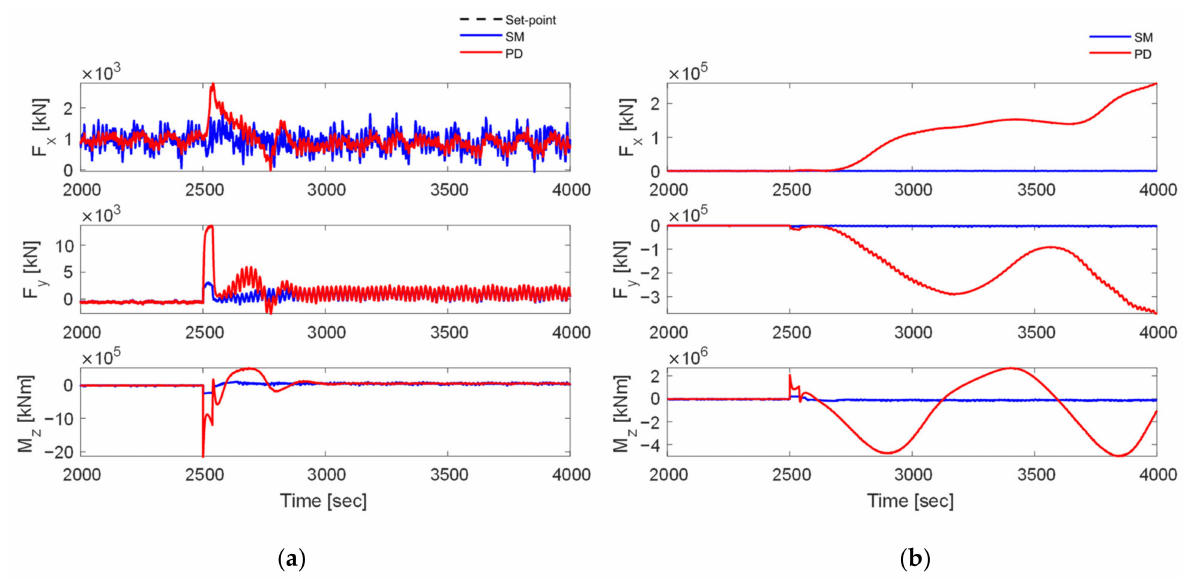
Figure 13. Simulation results of the control forces of FPSO vessel with comparison of the SM and PD controllers according to: ( a ) case 1 and ( b ) case